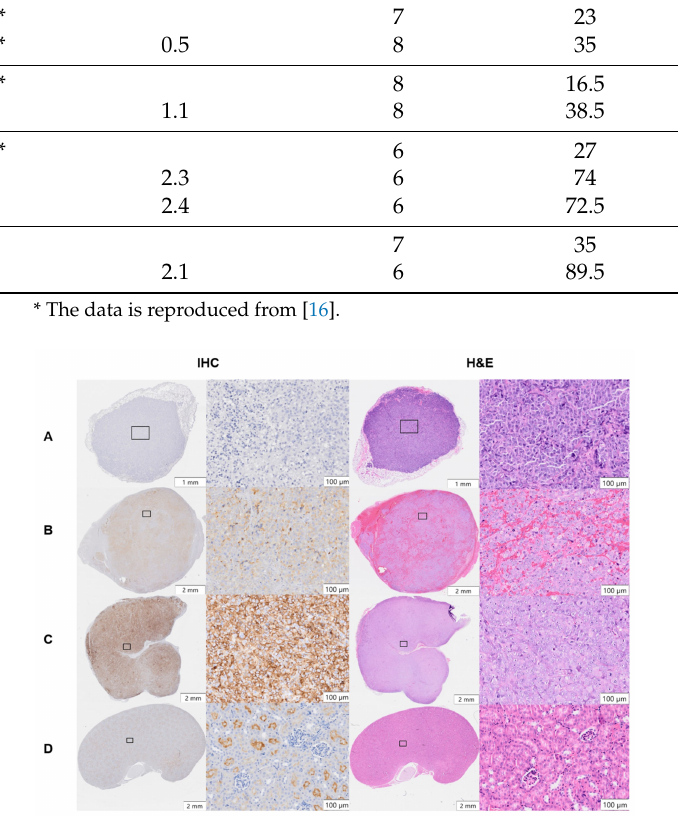
Figure 5. Immunohistochemical (IHC) PSMA staining and hematoxylin and eosin (H&E) staining of ( A ) PC-3 Flu, ( B ) C4-2, and ( C ) PC-3 PIP tumor xenografts and ( D ) kidneys of non-treated mice. Representative histological images ( × 20 magnification) were taken by using an automatic slide scanner (VS200, Olympus) and analyzed with VS200 ASW